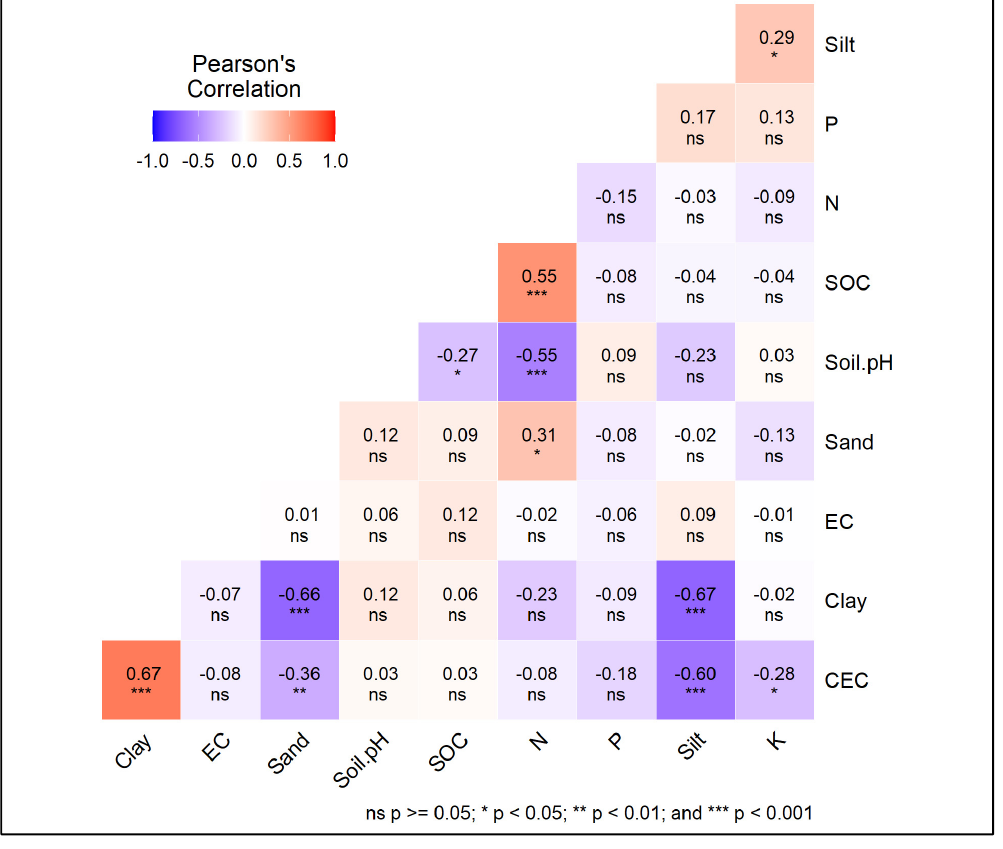
Figure 9. Pearson correlation between soil variables in semi-arid lowland district Kasur, Punjab